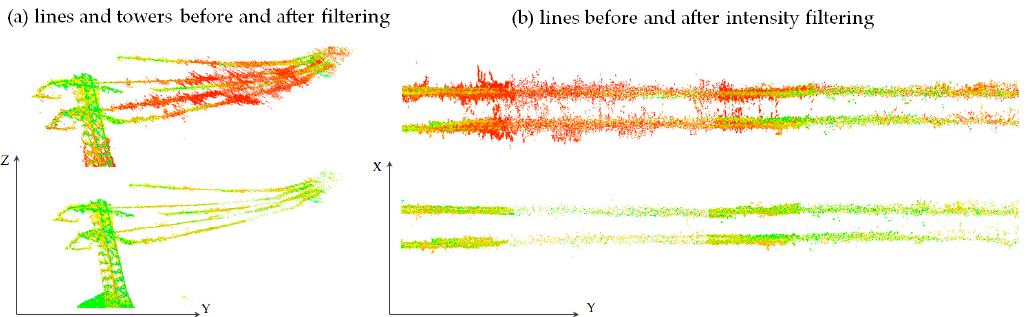
of wavelet analysis results.